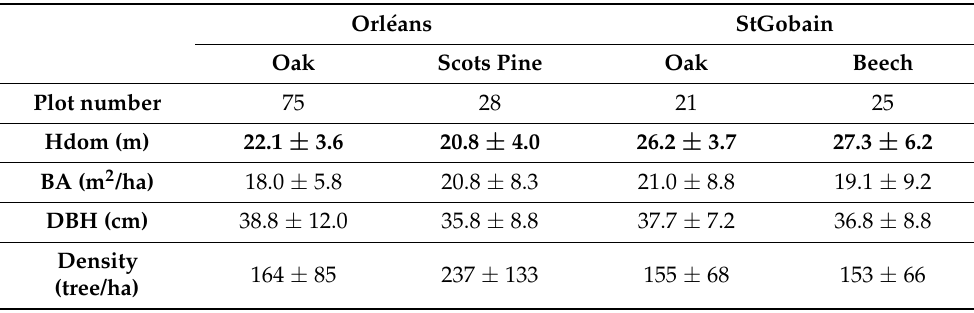
Table 1. Mean and standard deviation of field inventory for basal area (BA), mean DBH (DBH), dominant height (Hdom) and tree density